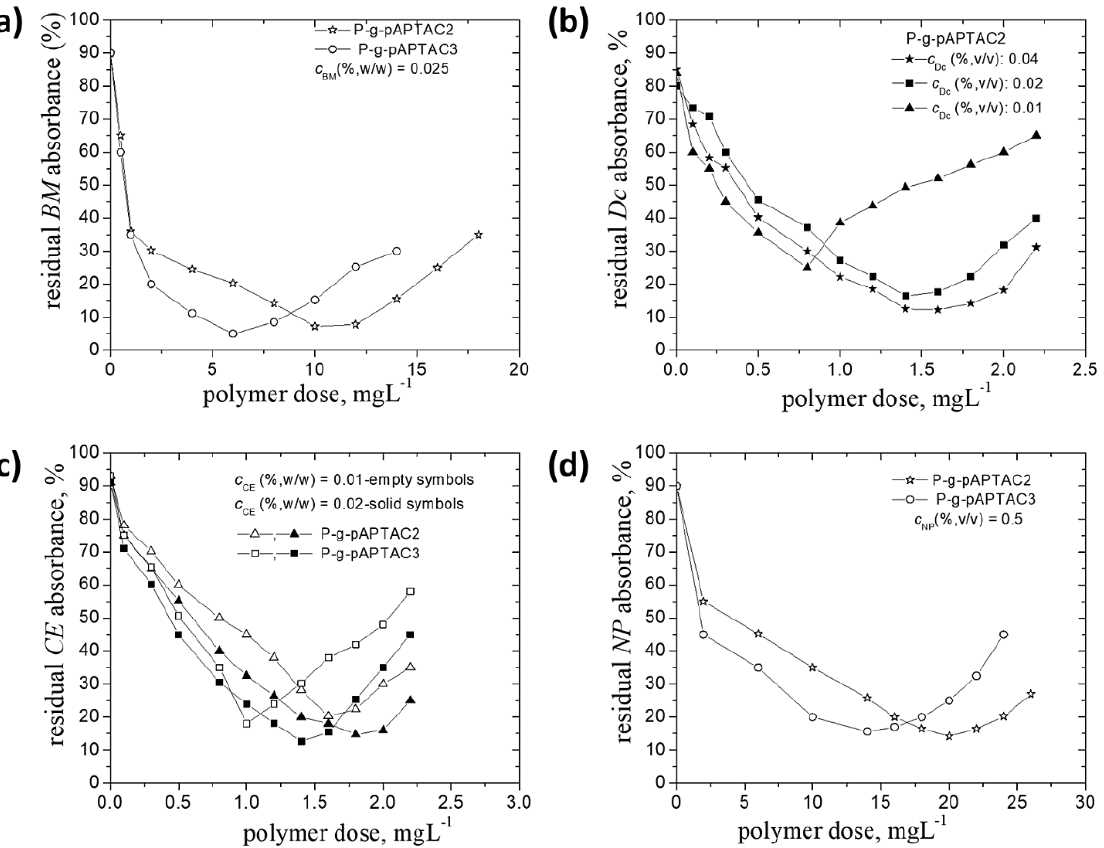
Figure 7. The residual pesticides absorbance (%) dependence on the polymer dose in dispersions with different concentrations of pesticides: BM ( a ), Dc ( b ), CE ( c ), NP ( d ). Both polymers showed the same behavior for all pesticides, at the new concentra- lowest dose op values were found for the P- g -pAPTAC3 sample and the largest dose op in- tervals for P- g -pAPTAC2. However, there are some differences indicating the impact of the initial emulsions concentration on the removal pesticides efficiency. Thus, for the same pesticide, the dose op values decreased with the decline of pesticide concentration (Table 4). Table 4. Optimum dose corresponding to the pesticide dispersion concentration.